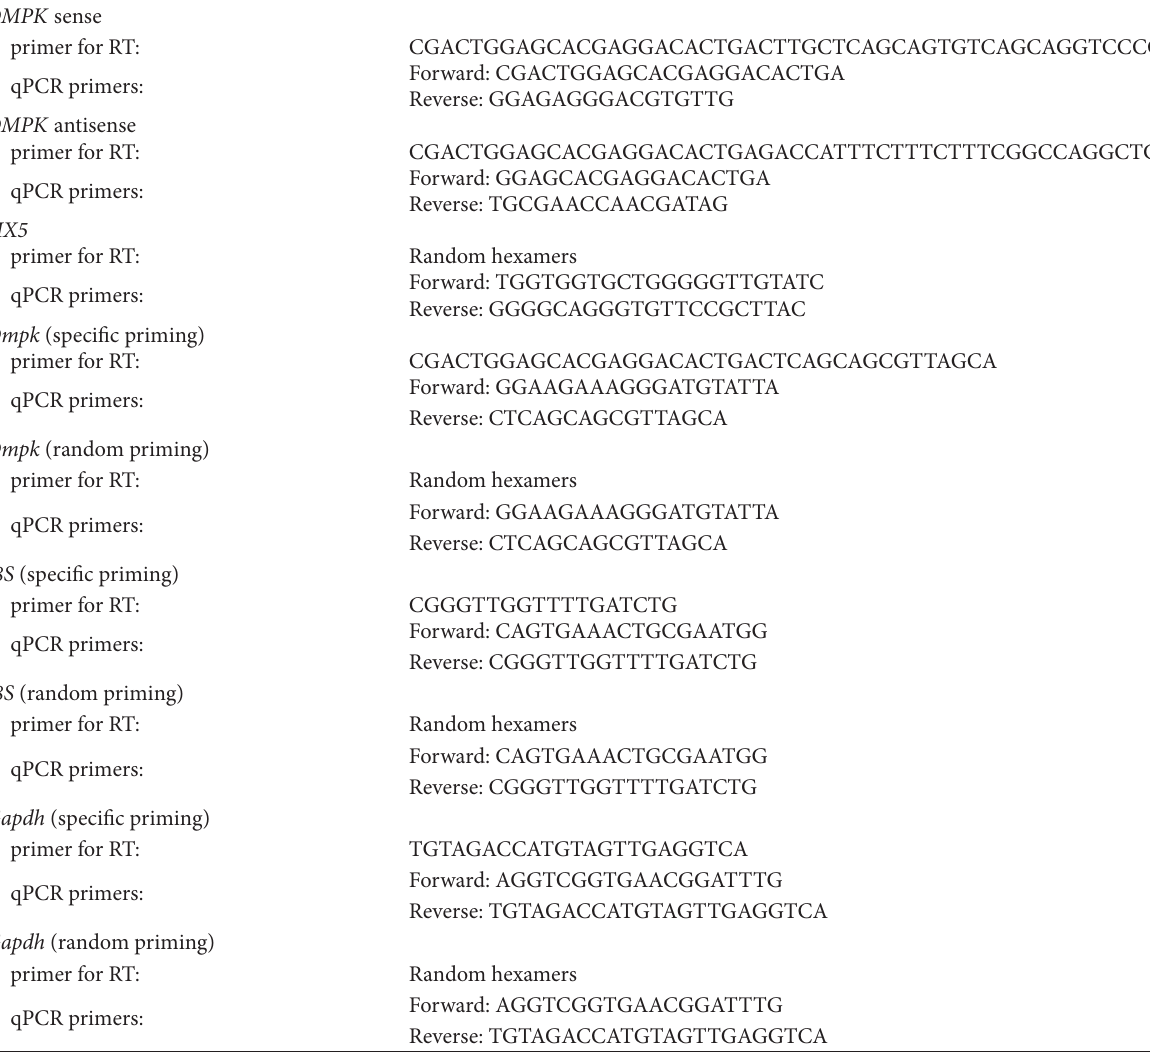
Table 1: List of primers used for expression